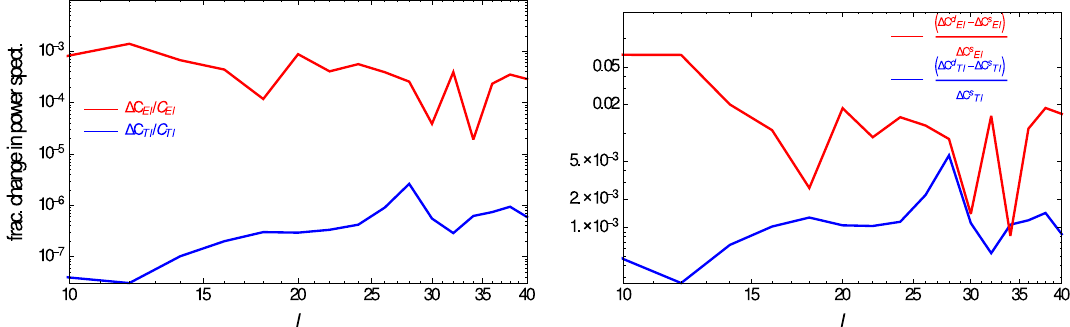
Fig. 2 The left panel shows plot for σ 2 red curve is for the weak lensing with the dipole distribution. The fractional change in l ( l + 1 ) C B axis